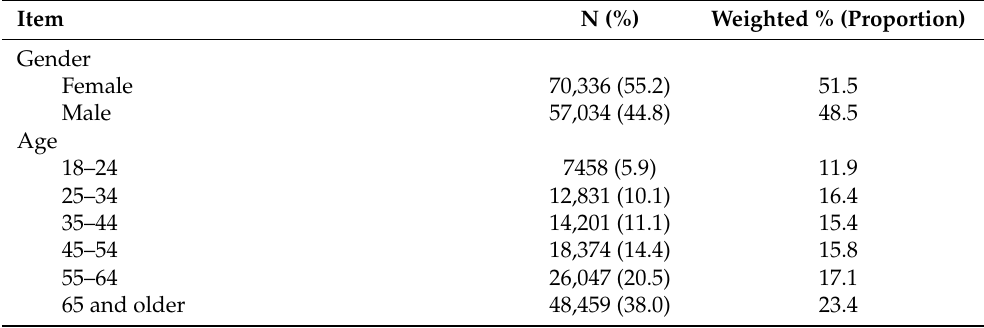
Table 1. Sample demographic information in 17 states in the 2019 BRFSS ( n = 127,370).